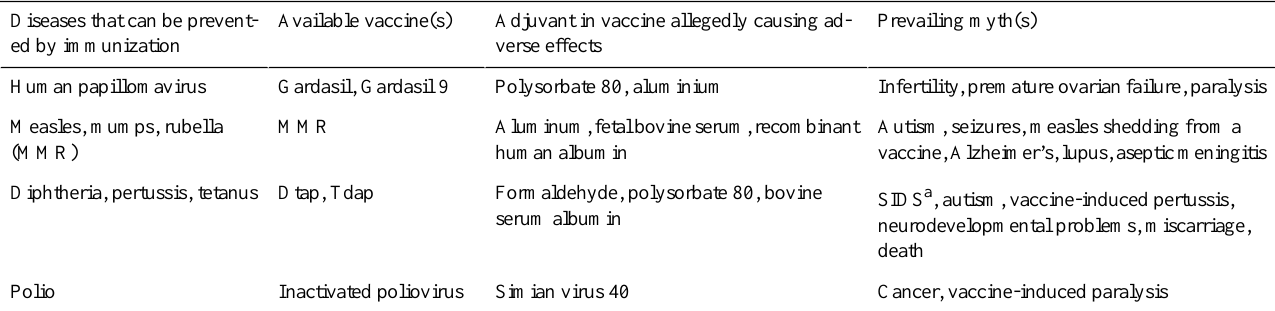
Table 1. Vaccines and their alleged